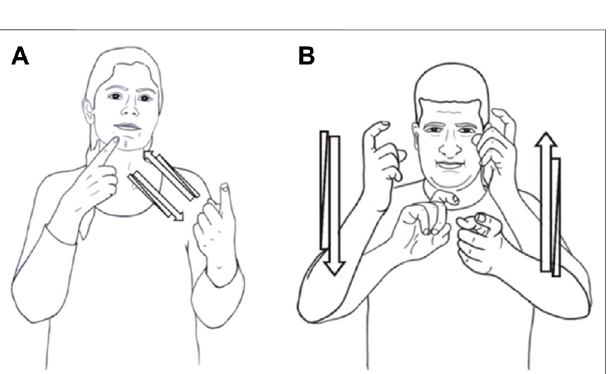
FIGURE 3 | Signs for NEGOTIATE/DISCUSS in (A) ISL and (B) ABSL. Two-handedness andrepeatedalternatingmovementareiconicandsimilarin these otherwise different